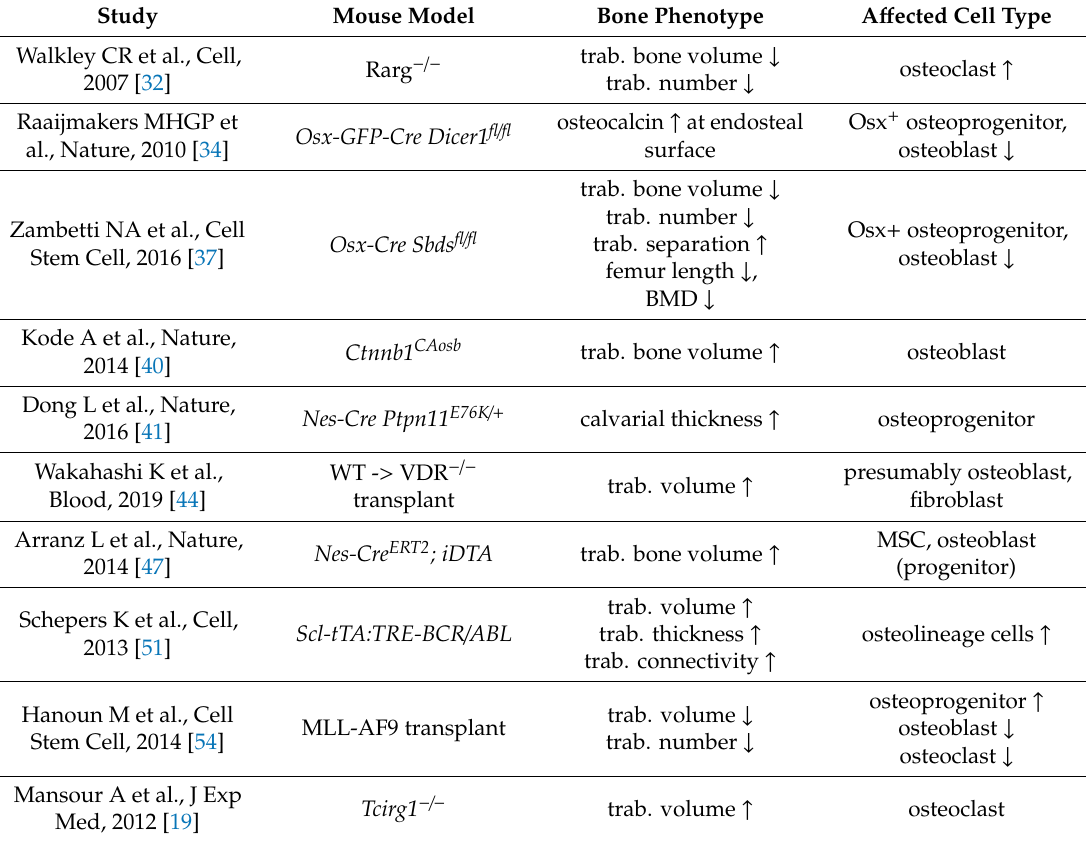
Table2. Overviewofbonephenotypesinselectedmousemodelsofmyeloidneoplasia. Thestudieslisted above reported bone phenotypes either by histomorphometrical measurements ( µ CT) or histological findings. Abbreviations: BMD: bone mineral density, trab.: trabecular, VDR: vitamin D receptor, WT: wildtype; in case of numeric alterations of an a ff ected cell type or bone phenotype parameter: increase ( ↑ ) and decrease ( ↓ ) are indicted with an